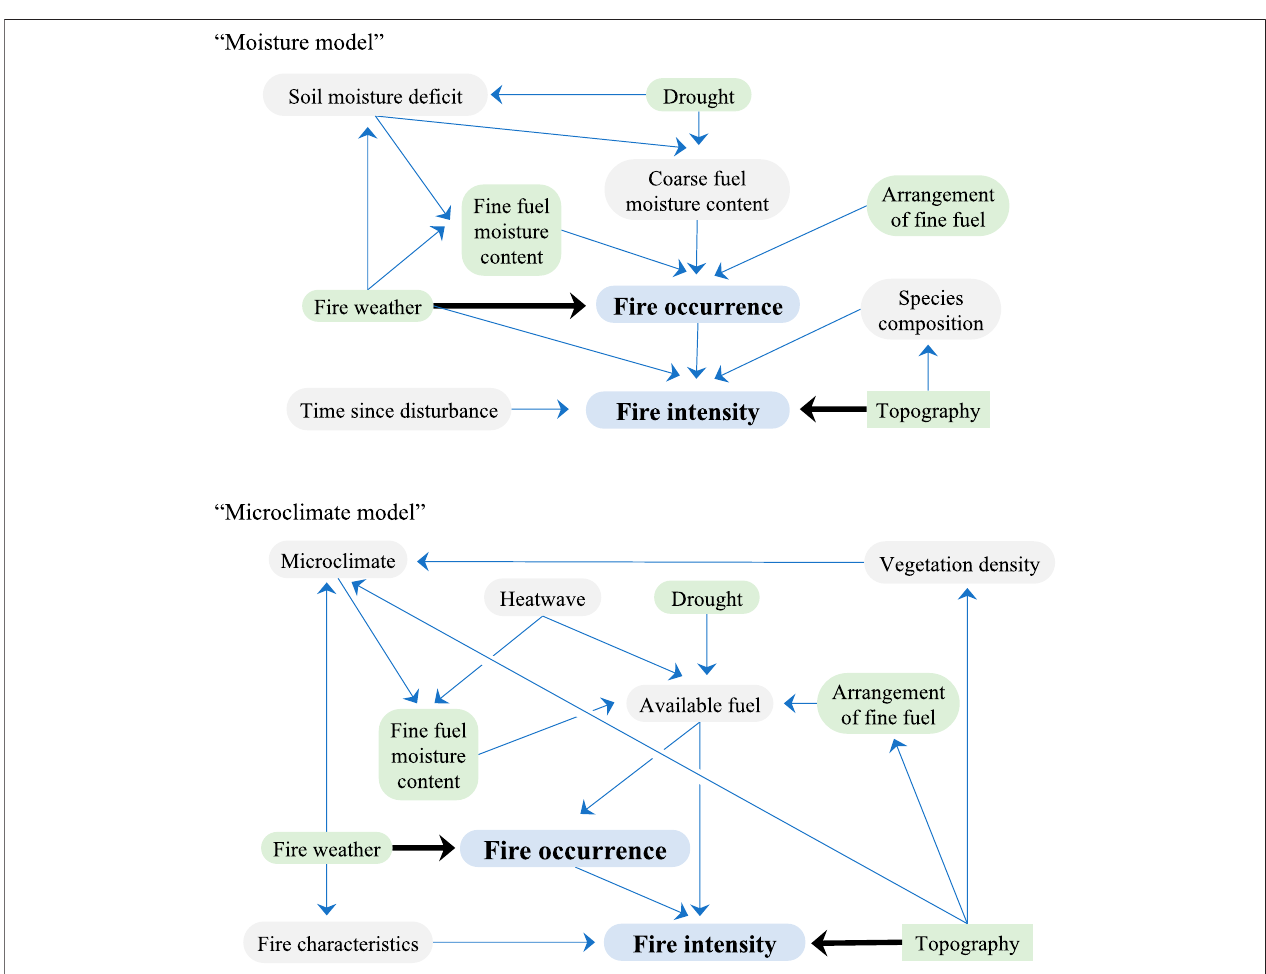
FIGURE 2 | Conceptual models for fi re occurrence and fi re intensity in eastern Australian forests developed by two independent groups of workshop participants (after [34]); one group focused on moisture and the other on microclimate. Factors unique to each model are shaded in gray. Common factors are shaded in green. Common arcs (links) are represented by heavy